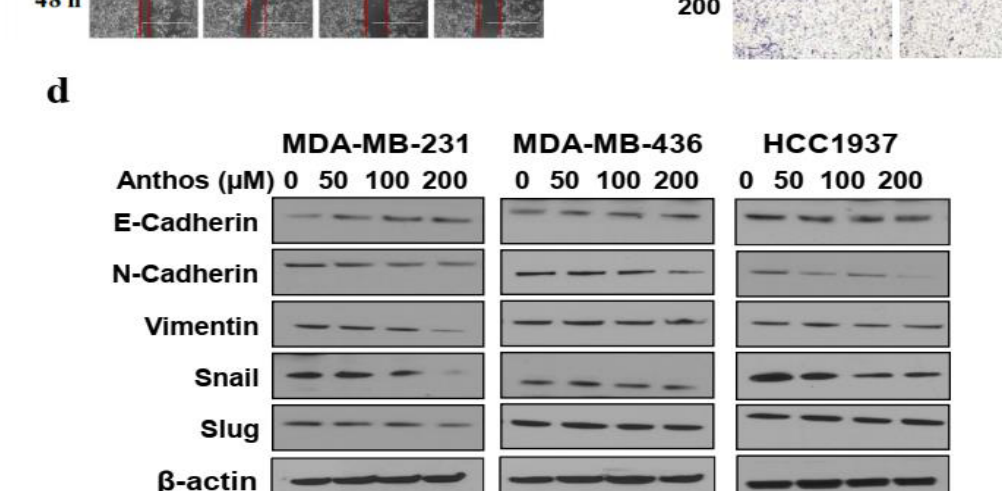
Figure 3. Effect of Anthos on cell migration, invasion, and EMT pathway proteins: ( a ) BC cells seeded in 2-Well Culture- Insert in a 24-well plate (Ibidi ® , Munich, Germany), resulting in a 1 mm wide wound. The inserts were removed after overnight incubation and cells were treated with Anthos (0–200 μM). Migration was assessed after 24 h and 48 h of Anthos treatment, represented as the percentage reduction in wound area; ( b , c ) Cells seeded in matrigel-coated transwell inserts. The bottom chamber was treated with Anthos (0–200 μM) in the absence ( b ) and presence ( c ) of TGFβ. Invasive cells at the bottom of the trans-well insert were visualized after staining with 0.2% toluidine blue; ( d ) Cells were treated with Anthos (0–200 μM) for 48 h and whole-cell lysates were probed for EMT pathway proteins. Equal loading confirmed by β-actin. Densitometry data from panel D are presented in Figure S9.